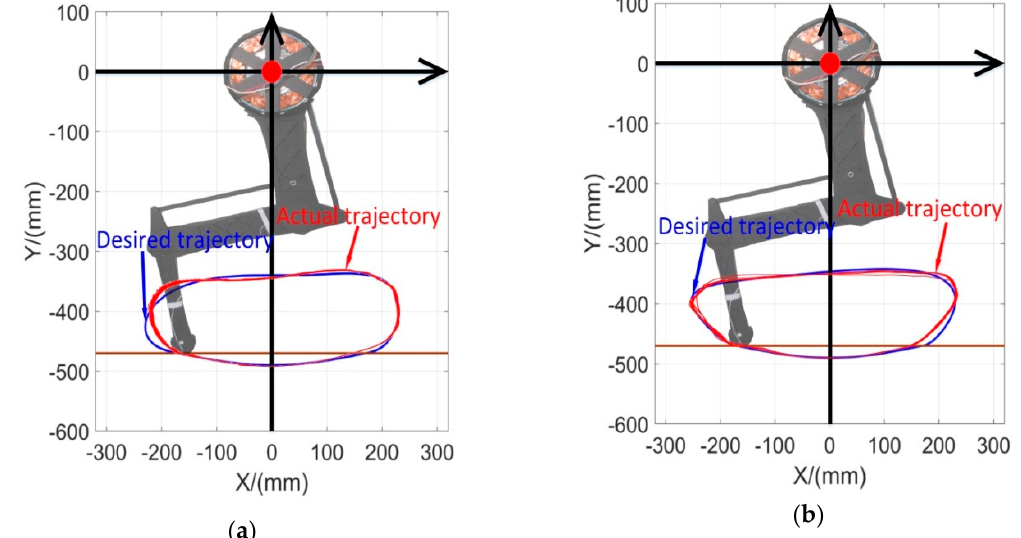
Figure 19. The desired and actual trajectory with V desired = 2 m / s. ( a ) The trajectory of the scheme I. ( b ) The trajectory of the scheme II.